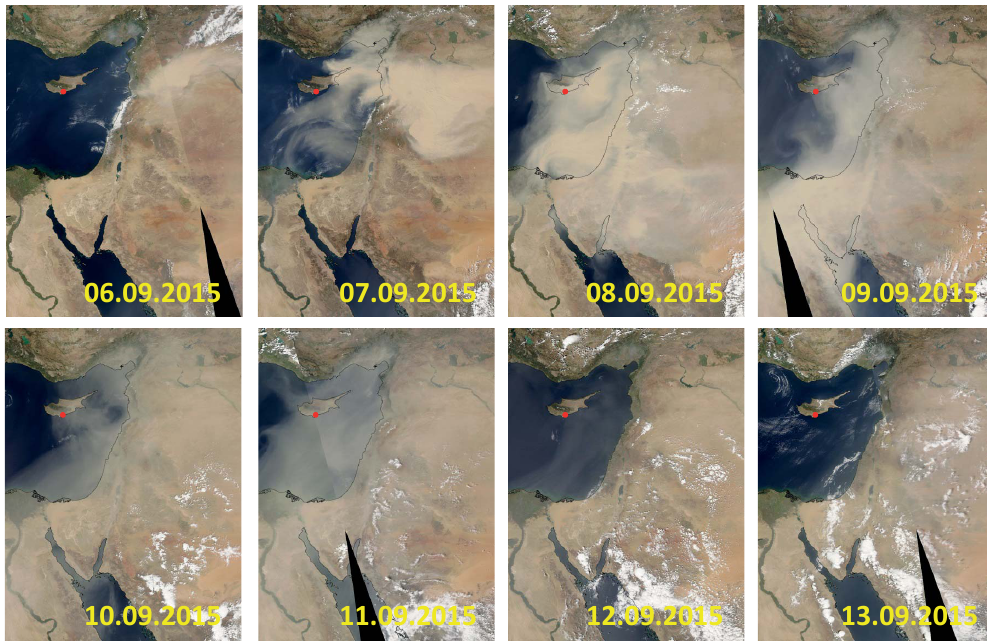
Figure 2. Dust outbreak towards Cyprus in September 2015 as seen from space (aqua-MODIS, 10:30–11:30UTC overpasses, 13:30– 14:30EEST, Eastern European Summer Time). Red points indicate